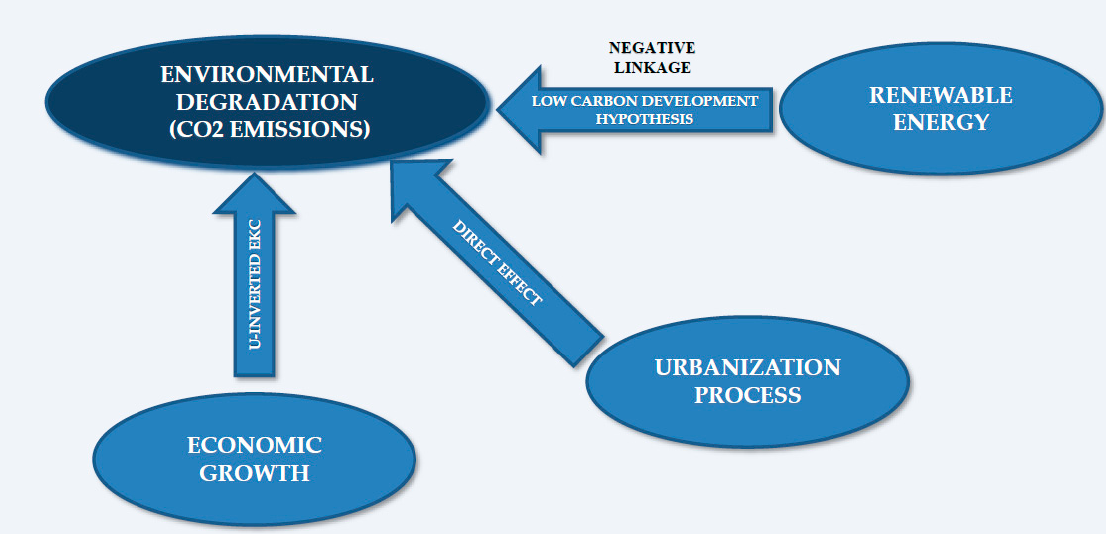
Figure 2. Summary of impacts between variables.